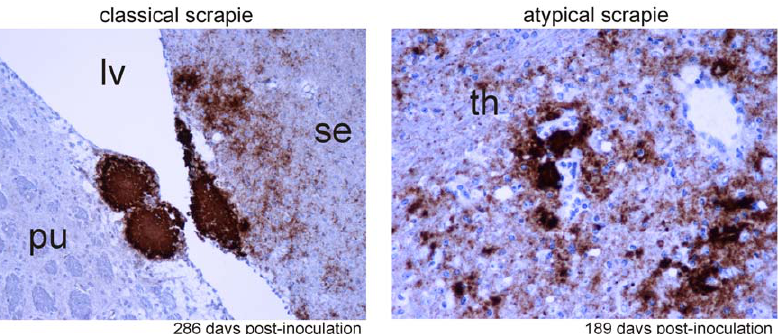
Figure 5. Localization and size of plaque-like PrP deposits in atypical and classical scrapie. In atypical scrapie-inoculated mice, relatively small plaques were observed in the neuropil (40X magnification), while the plaques in the classical scrapie-inoculated mice were larger, coalescing and always associated to the leptomeninges and the ependyma (20X magnification). PrP d immunoreactivity was detected using the mAb SAF84. Neuroanatomical structures: septal nuclei (se), caudate putamen (pu), lateral ventricle (lv) and thalamus (th).